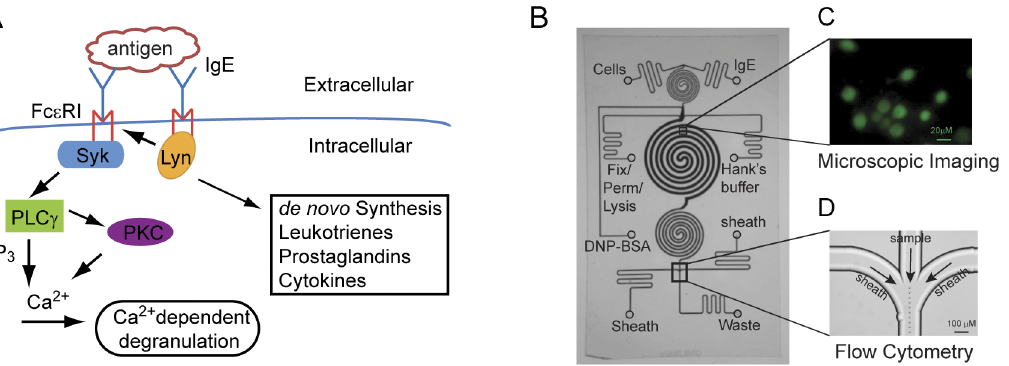
Figure 1. A microfluidic chip for measuring IgE-mediated Fc e RI signaling events. A) General scheme of Fc e RI signaling. Crosslinking Fc e RI, the high-affinity IgE receptor, through IgE-Fc e RI interaction with mulitvalent antigen activates the signal-initiating kinase Lyn, creating receptor binding sites for the signal-propagating kinase Syk. Syk activation leads within minutes to the tyrosine phosphorylation of many proteins, mobilization of cellular Ca 2 + , the release of inflammatory mediators via degranulation and within hours to cytokine production. B) Micrograph of the monolithic microfluidic chip used in this study. The inlets used for individual cell/reagent loading, buffer washing and intracellular immunostaining are indicated in the figure. C) Selected regions for live-cell imaging. Scale bar: 20 m m. D) Hydrodynamic focusing and detection region for m flow cytometry.